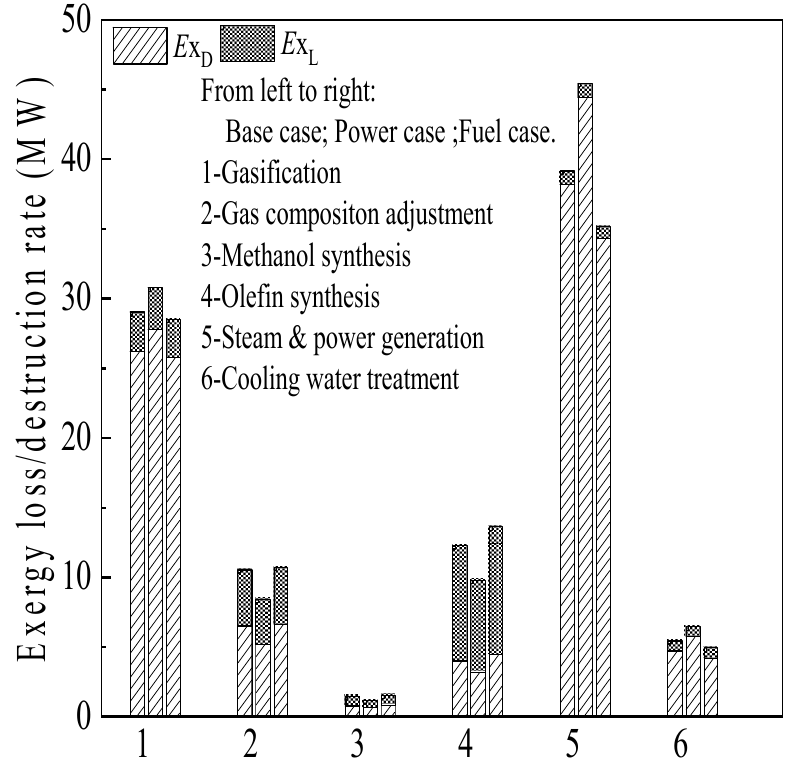
Figure 3. Exergetic loss/destruction rate at the subsystem level for each case.